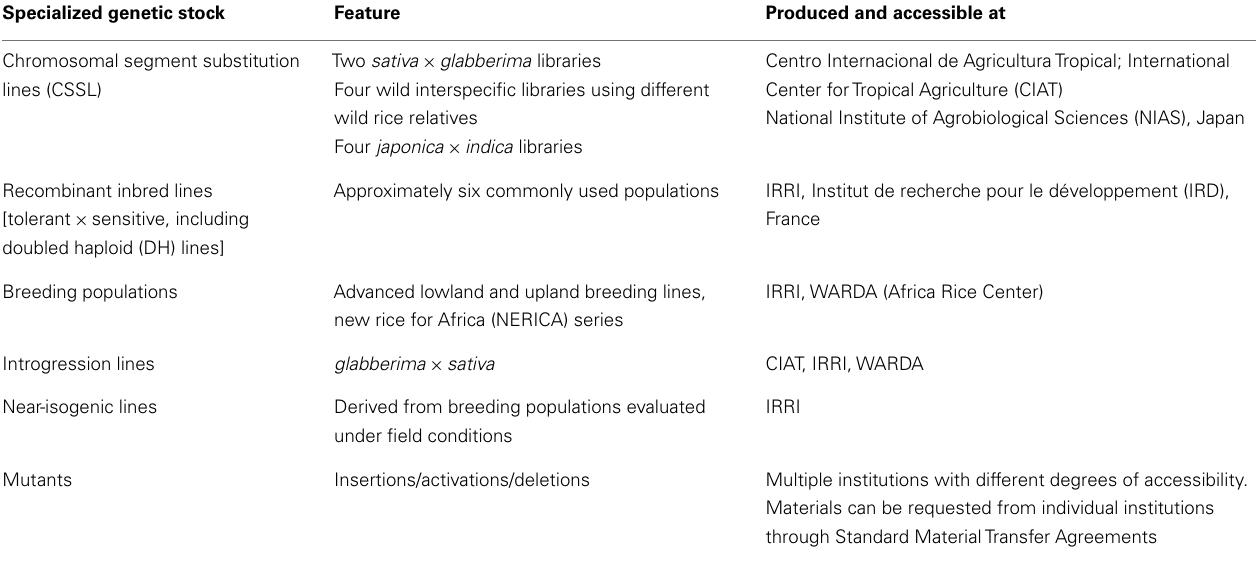
Table 1 | Overview of rice genetic resources useful for drought research and